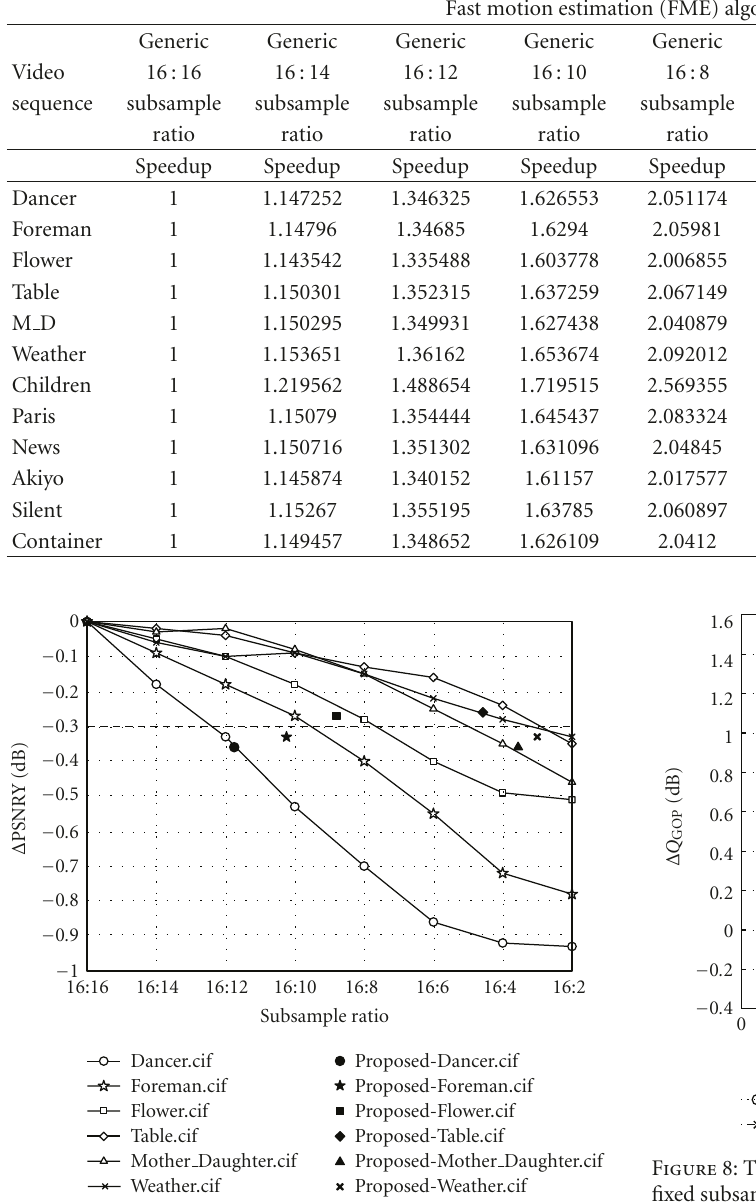
Figure 7: The quality degradation chart of FSBM with fixed subsample ratios and proposed algorithm.